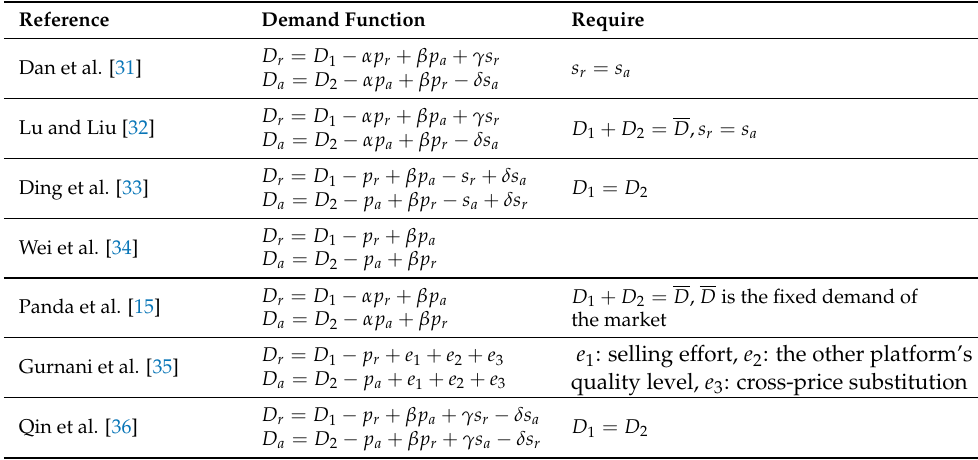
Table 2. Specific demand functions of two